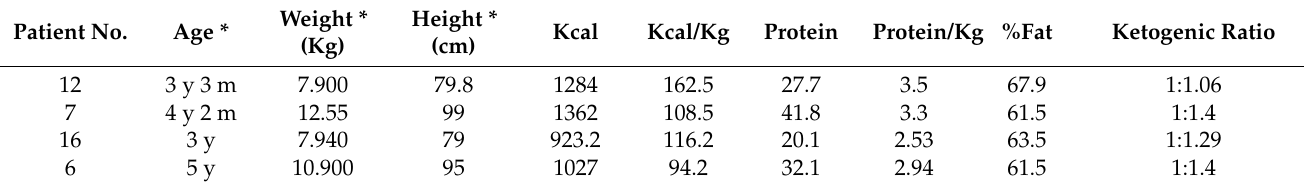
Table 1. Details of ketogenic diet for each